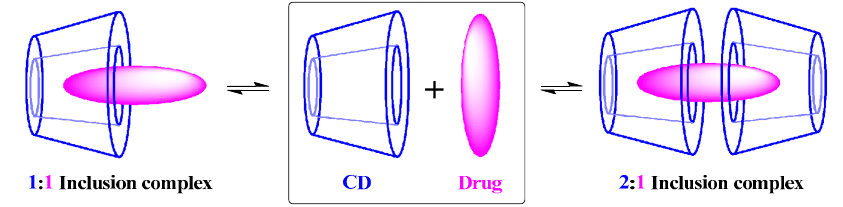
Figure 4. Two examples of stoichiometry adopted by CD–drug inclusion complexes.